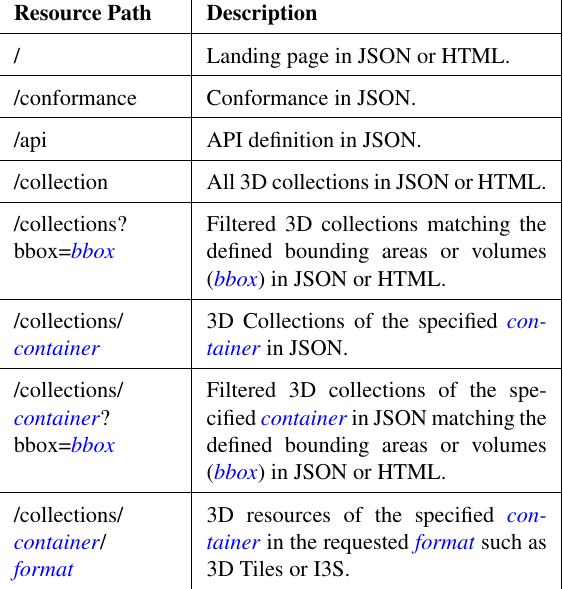
Table 1. The path and result from the OGC API 3D GeoVolumes resources.